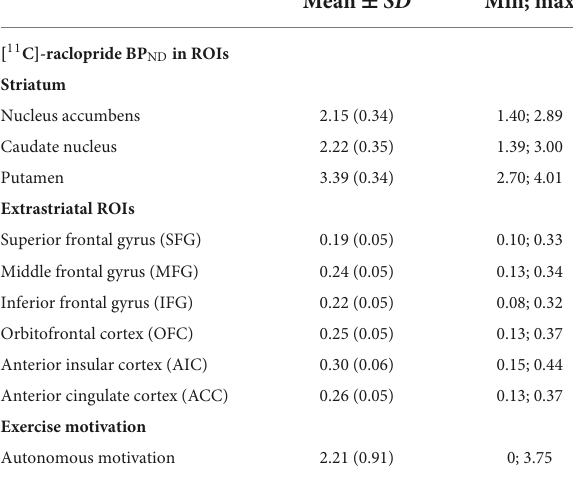
TABLE 2 Descriptive information of D2/3R availability as [ 11 C]-raclopride BP ND for each brain region of interest, and self-reported autonomous motivation.